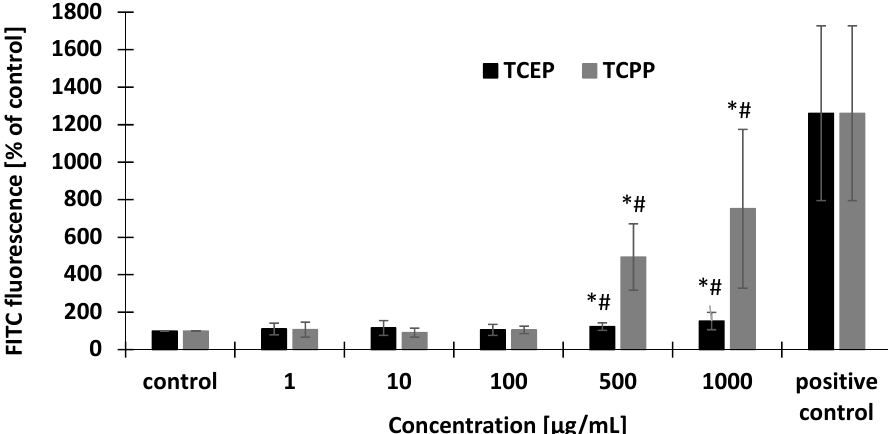
Figure 2. Hemolysis level in control erythrocytes and erythrocytes incubated with TCEP and TCPP Figure 3. Changes in phosphatidylserine externalization (eryptosis) in control erythrocytes and erythrocytes incubated with in the concentrations from 0.001 to 1000 μ g/mL for 24 h. * p < 0.05 indicates statistically significant Figure 3. Changes in phosphatidylserine externalization (eryptosis) in control erythrocytes and erythrocytes incubated difference from control; (#) statistically significant difference between TCPP and TCEP. One-way TCEP and TCPP in the concentrations from 1 to 1000 µ g/mL for 24 h. Positive control-cells incubated with valinomycin. with TCEP and TCPP in the concentrations from 1 to 1000 μ g/mL for 24 h. Positive control-cells incubated with valinomy- analysis of variance (ANOVA) and a posteriori Tukey test. cin. * p < 0.05 indicates statistically significant difference from control; (#) statistically significant difference between TCPP * p < 0.05 indicates statistically significant difference from control; (#) statistically significant difference between TCPP and and TCEP. One-way ANOVA and a posteriori Tukey test. TCEP. One-way ANOVA and a posteriori Tukey test. 3.2. Quantification of Eryptosis—Analysis of Phosphatidylserine (PS) Externalization Changes in the FITC fluorescence were observed in the erythrocytes treated with TCPP and TECP at concentrations of 500 μ g/mL and 1000 μ g/mL after 24 h of incubation (Figure 3). TCPP caused stronger eryptotic changes than TCEP (#).